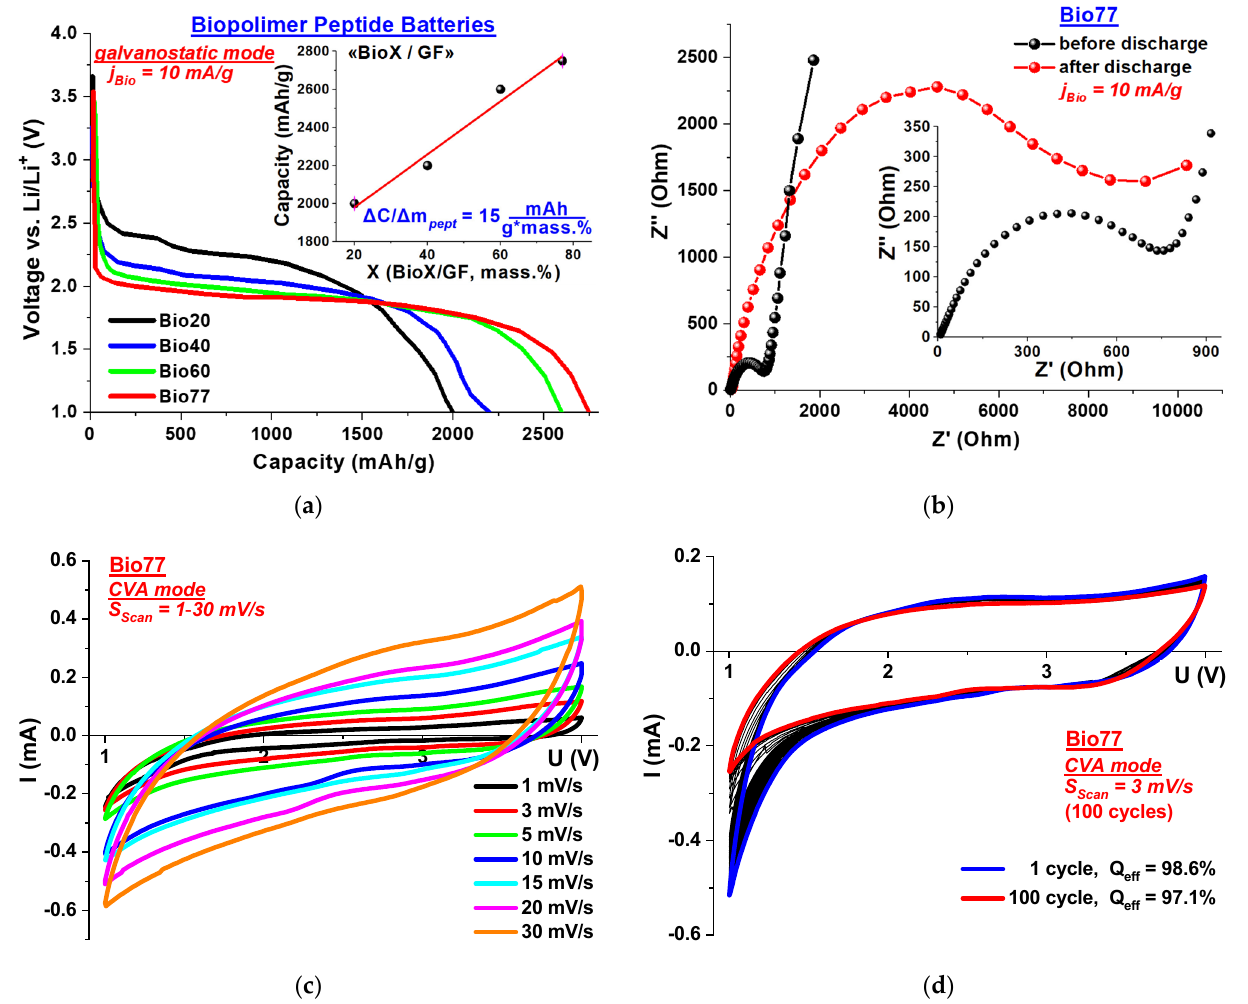
Figure 1. Electrochemical testing of “Biopolimer Peptide Batteries” with BioX cathodes:( a ) discharge curves in galvanostatic mode for different organic component content X = 20-77 wt% (the inset shows the corresponding concentration dependence of the specific capacity of batteries); ( b ) Nyquist diagrams for the Bio77 case before and after discharge to 1.0 V at a current of 10 mA/g (the high-frequency region is scaled in the inset); ( c , d ) CVA curves for the Bio77 case at different rates of potential change and a sweep over 100 cycles at a rate of S Scan = 3 mV/s, respectively.